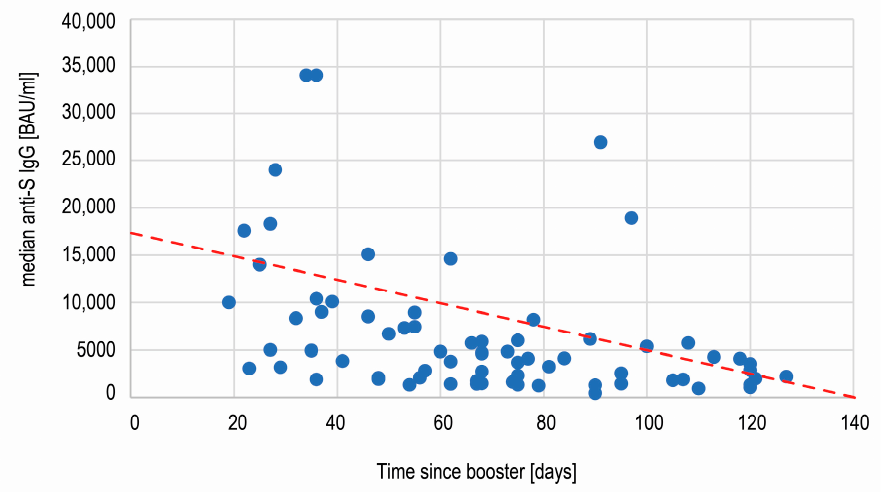
Figure 6. The negative correlation (R = − 0.48, p < 0.00001) between the anti-spike SARS-CoV-2 IgG concentration and time passing after the third Comirnaty dose administration.